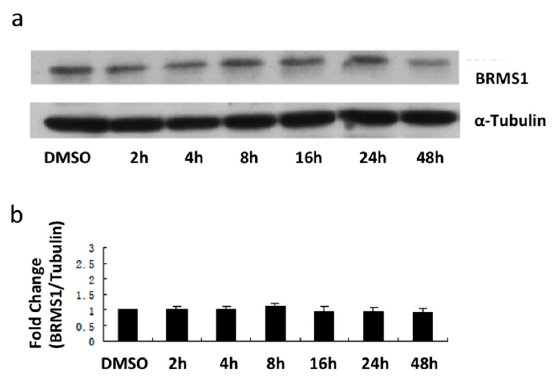
Figure 2. Western analysis of BRMS1 protein expression induced by E 2 in MCF-7 cells. ( a ) Cells were incubated with culture media containing 10 nM E 2 for 2, 4, 8, 16, 24, and 48 h. Control cells were incubated with culture media containing 10 nM DMSO for 2 h. At each time interval, cells were harvested and 20 µg of the total protein was loaded for each sample to determine BRMS1 expression by Western blot. α -tubulin was used as the loading control. Each band present was quantified using Image J and a set area encompassing the BRMS1 band was divided by the same area for α -tubulin from the same lane to determine the relative amount of BRMS1 expression. The DMSO value was set to 1 for comparisons; ( b ) The bar graph summarizes BRMS1 protein normalized to α -tubulin from the same lane in three independent experiments. Error bars were the average of three independent experiments ± SD. * indicates statistical significance at the p < 0.05 level compared to DMSO.